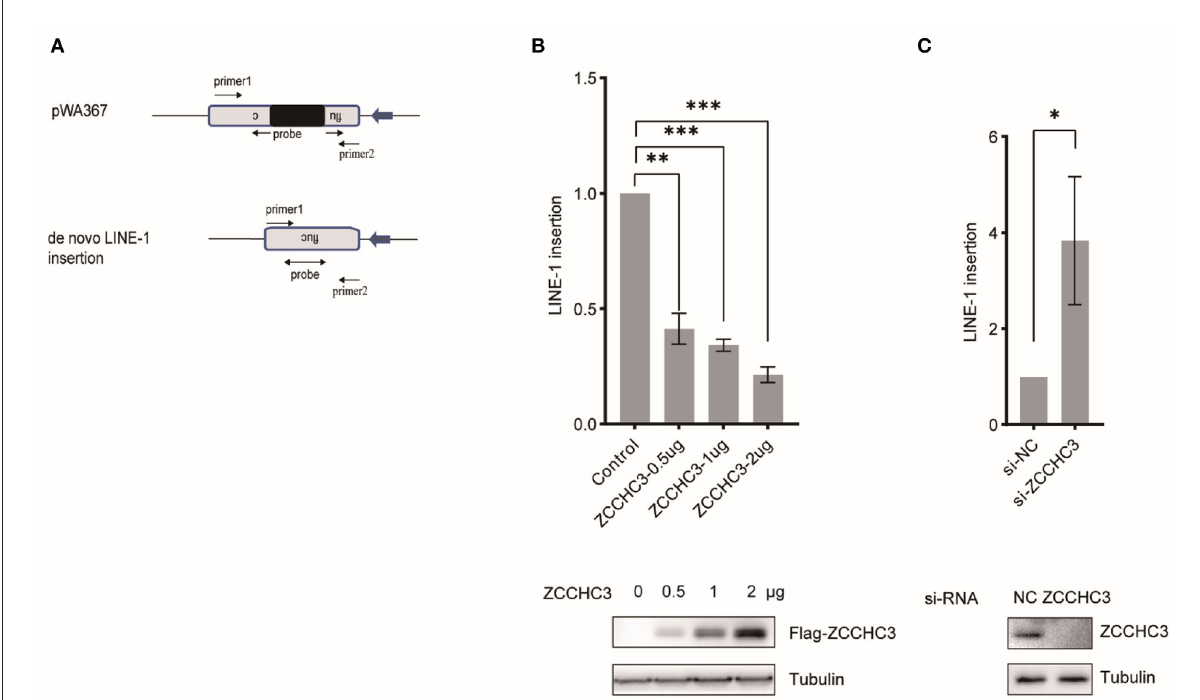
FIGURE2 ZCCHC3 decreased LINE-1 insertions. (A) Diagrams of Taqman real-time PCR to detect novel LINE-1 integrates. The real-time PCR was performed with two primers and one probe across the intron to detect the integrated novel LINE-1. (B) Overexpression of ZCCHC3 decreased novel LINE-1 integrates. HEK293T cells were transfected with pWA367 and ZCCHC3 DNA. Four days post-transfection, genomic DNA was extracted and analyzed for Taqman real-time PCR (top panel). Expression of the Flag-ZCCHC3 was analyzed by immunoblot, and Tubulin was detected as an internal control (bottom panel). (C) Knockdown of ZCCHC3 increased novel LINE-1 integrates. HEK293T cells were transfected with pWA367 together with the siRNA targeting ZCCHC3. Four days post-transfection, genomic DNA was extracted and analyzed for Taqman real-time PCR (top panel). Expression of the ZCCHC3 was analyzed by immunoblot, and Tubulin was detected as an internal control (bottom panel). Data are representative of at least three independent experiments, values are expressed as means ± SD, and representative blots and images are